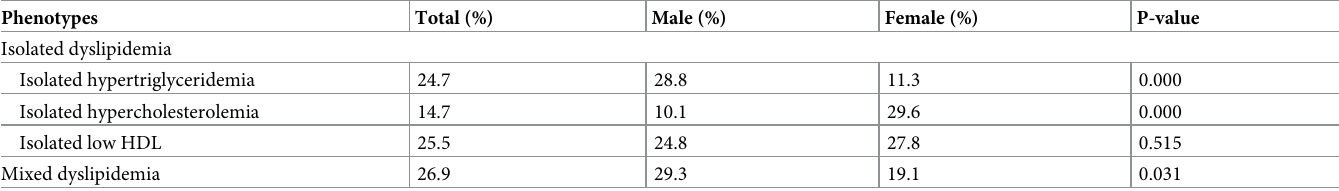
Table 4. Prevalence of dyslipidemia according to isolated and mixed phenotypes.